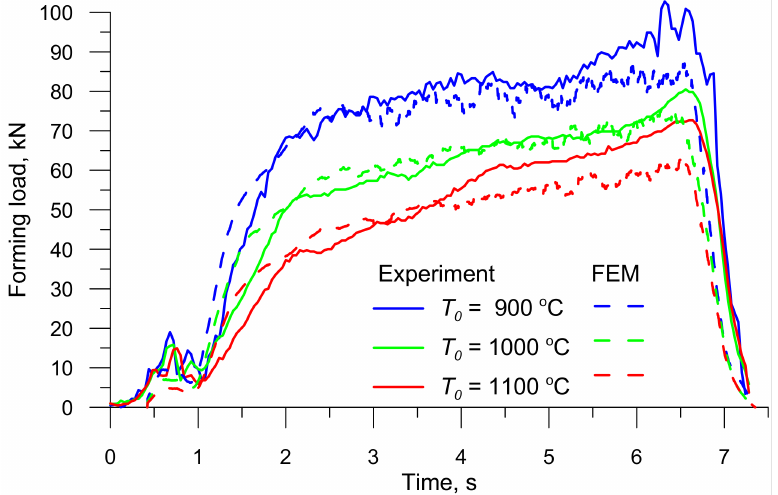
Figure 10. Experimental and FEM (Finite Element Method) forming loads in the CWR test versus billet temperature T 0